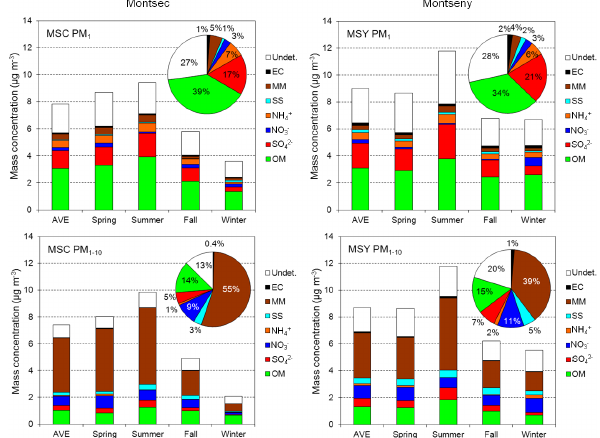
Figure 3. Average concentrations of aerosol major components in PM 1 and PM 1 − 10 fractions at Montsec and Montseny for the whole period (AVE) and for different seasons based on daily measure- ments between January 2010 and March 2013. Pie charts represent the average relative contribution of aerosol major components to total mass for each